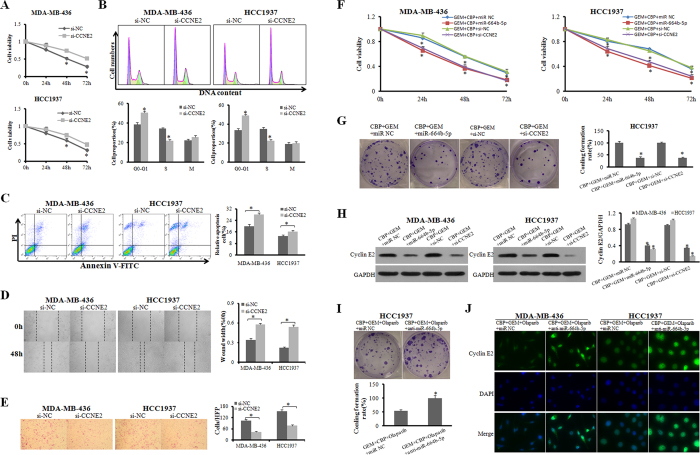
CCNE2 knockdown revealed similar effects as that of ectopic miR-664b-5p expression.(A) The influence of CCNE2 on the cell growth of BRCA1-mutated TNBC cells was measured with an MTT assay. (B,C) The representative images of cell apoptosis and cell cycle were analysed by flow cytometry in MDA-MB-436 and HCC1937 cells transfected with si-CCNE2 or si-NC. (D,E) Wound-healing and Transwell assays in MDA-MB-436 and HCC1937 cells were performed after transduction with si-CCNE2 or si-NC. (F) The influence of adding miR-664b-5p overexpression or CCNE2 interference to CBP plus GEM treatment on the cell growth of BRCA1-mutated TNBC cells was measured with an MTT assay. (G) Colony formation of HCC1937 cells transfected with miR-664b-5p mimics or si-CCNE2 after exposure to CBP plus GEM for 72 h. (H) Western blot analysis of cyclin E2 protein in miR-664b-5p-overexpressing cells. GAPDH expression was used as the loading control. (I) Colony formation of HCC1937 cells transfected with miR-664b-5p inhibitors or miR-NC after exposure to CBP plus GEM combined with olaparib for 72 h. (J) Fluorescence microscopy analysis of the expression of cyclin E2 by IF. The green signal represents the staining of cyclin E2 protein, and the blue signal represents the nuclear DNA staining by DAPI. *p < 0.05.